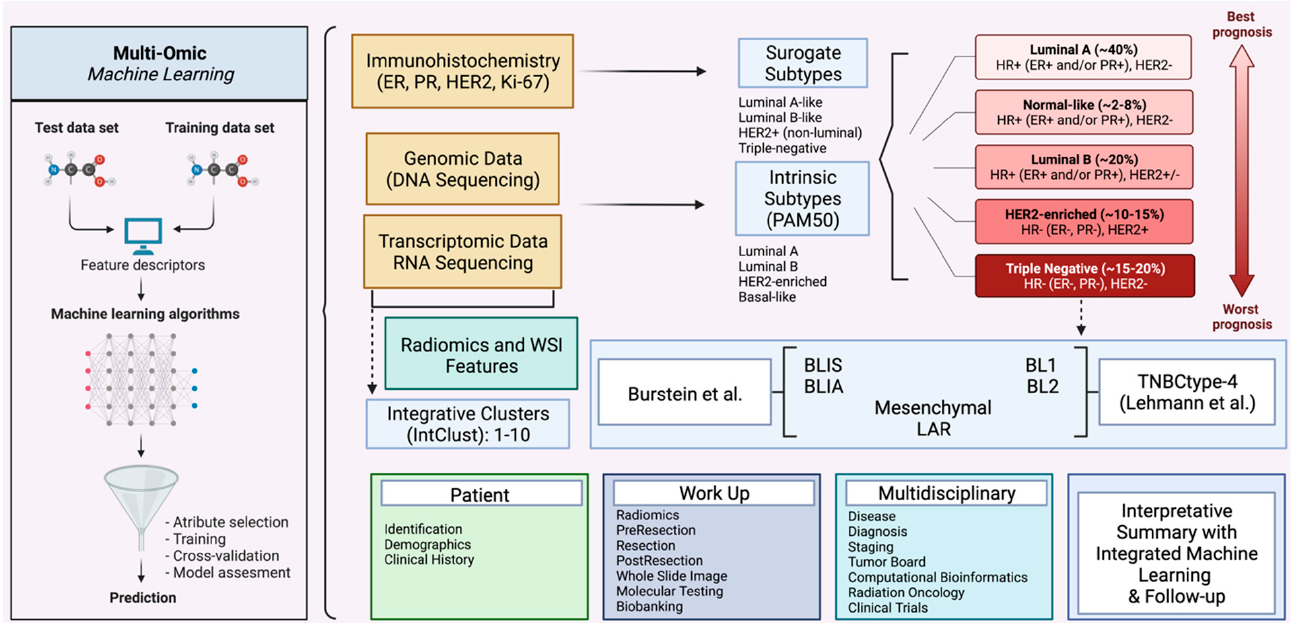
Figure 6. The precision breast cancer medicine digital ecosystem and diagnostic framework with integrated multi-omic machine learning. Immunohistochemistry is used as a surrogate marker, while genomic and transcriptomic data define intrinsic subtypes and integrative clusters of breast cancer with variable clinical significance. TNBC has the worst prognosis and contains subtypes such as luminal androgen receptor (AR; LAR), (ii) mesenchymal (MES), (iii) basal-like immunosuppressed (BLIS), and (iv) basal-like immune-activated (BLIA) as defined by Burstein et al. [22], and basal-like (BL1 and BL2) by Lehmann et al. [21]. The new digital ecosystem and diagnostic workflow rely on integrated ML, incorporating multi-omic features and reporting summary findings to clinicians in an understandable manner with follow-up. Adapted from the following references [21,22,128].